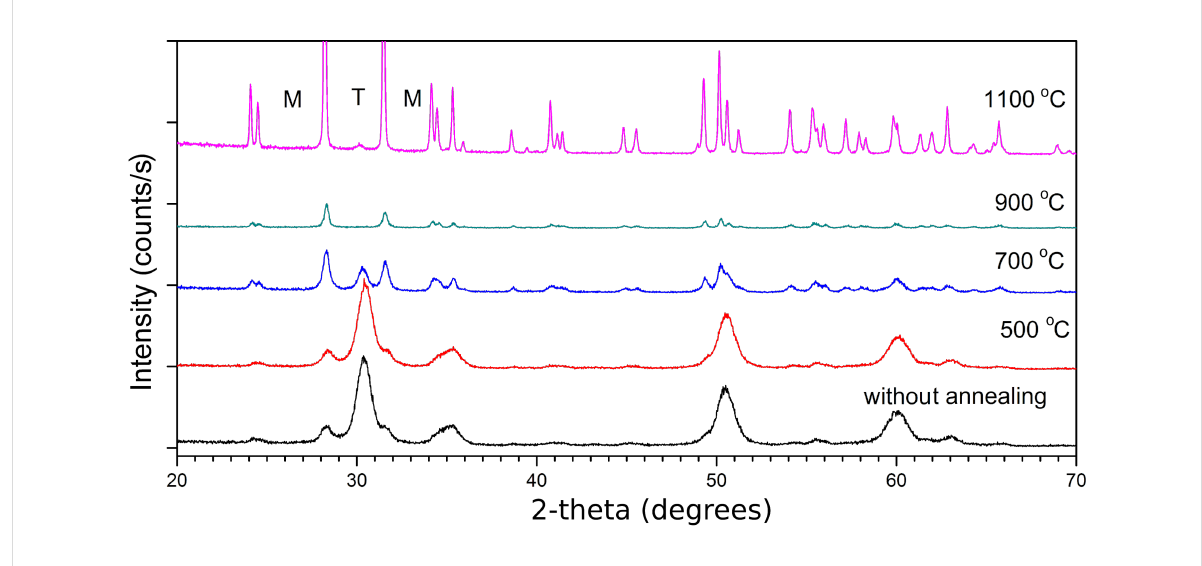
Figure 1: X-ray diffraction patterns of ZrO 2 synthesized at 5.5 MPa for 20 min and annealed in air for 30 min at the given temperatures. The diffrac- tion peaks assigned to the tetragonal phase and the monoclinic phase are marked as T and M, respectively.